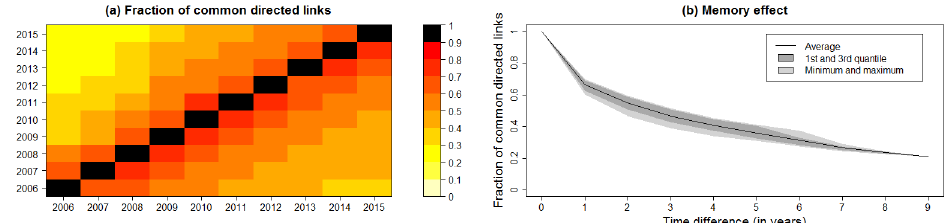
Fig 4. Fraction of common directed links. (a) Network loyalty (fraction of common directedlinks contained in two consecutive snapshots)of the pig movement network in Denmark between1 st January2006 and 31 st December 2015. Asymmetry is caused by varyingnumber of directed links per year. (b) Development of the fraction of common directedlinks per year time difference. Dark grey areas represent the interval between1 st and 3 rd quantile,light grey areas represent the interval betweenminimum and maximum values for the fraction of common